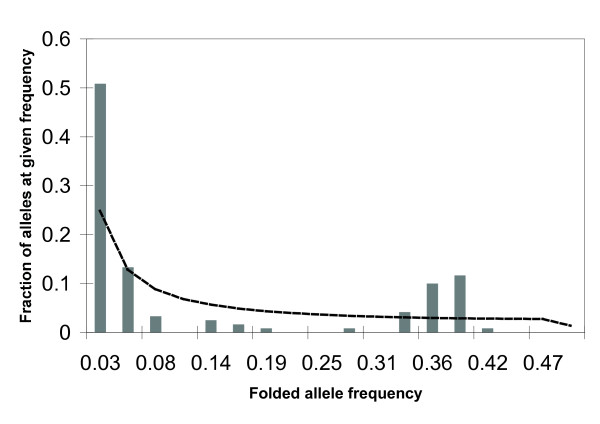
Folded allele frequency spectrum. The plots illustrate the expected (solid line) and observed (grey bars) frequencies of alleles, ranging from those present as singletons through those present in half (18/36) of ECB haplotypes sampled. The folded rather than unfolded spectrum is provided because the two ACB sequences are dissimilar, and therefore neither was used to infer the ancestral state. The observed allele frequency spectrum has a two-fold excess of singleton alleles (observed frequency of alleles present in a single individual = 0.508 [expected frequency = 0.248]) and three consecutive excesses of intermediate frequency alleles (observed frequency of alleles present in 12/36, 13/36, and 14/36 individuals = 0.0412, 0.100, and 0.117 [expected frequency = 0.030, 0.029, 0.028]).